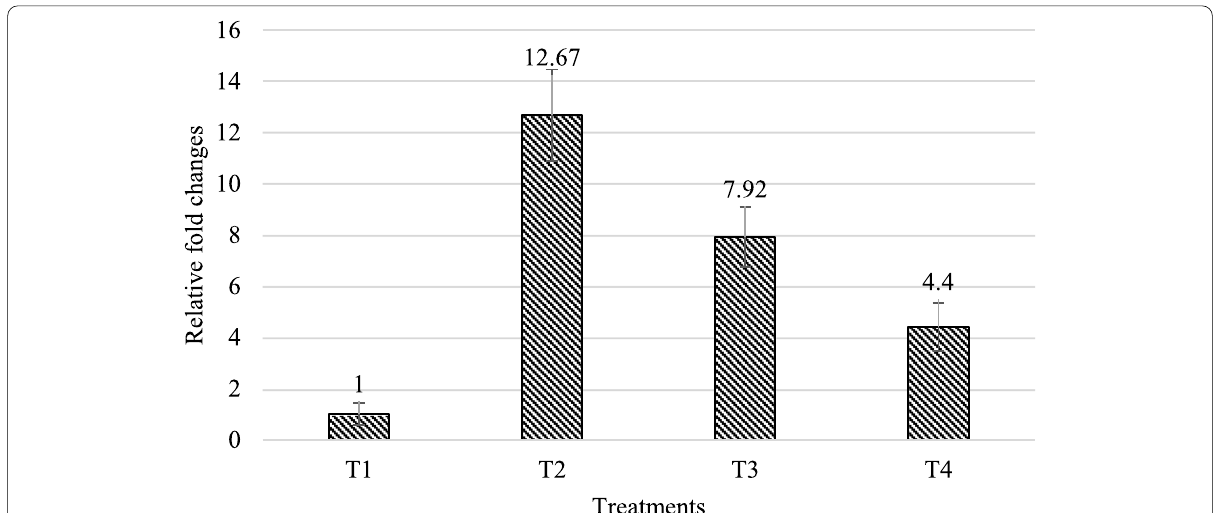
Fig. 3 The relative fold changes in the population of E. coli (O157: H7) in the ileum. T1: normal diet. T2: normal diet on day 21. T3: a normal diet enriched by a nonencapsulated phenolic-rich fraction (10 mg TPC/kg